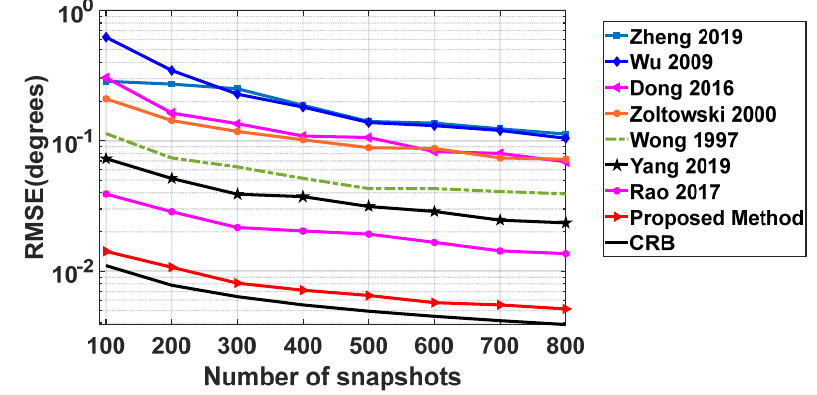
Figure 7. RMSE versus N .